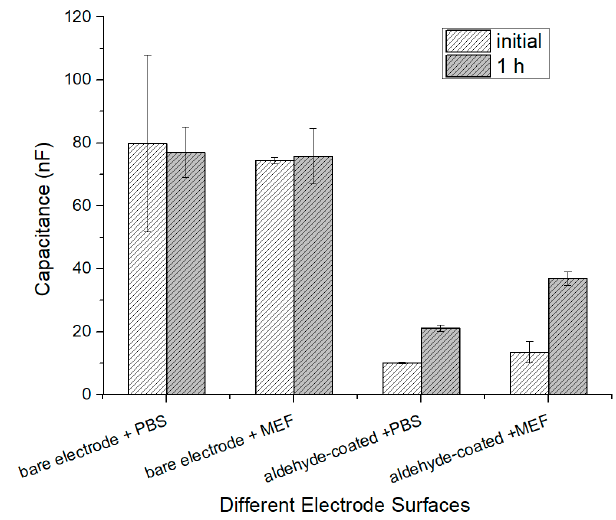
Figure 6. Response from bare electrode and aldehyde-coated electrode in phosphate-buffered saline (PBS) and mouse embryonic fibroblast (MEF) solution.